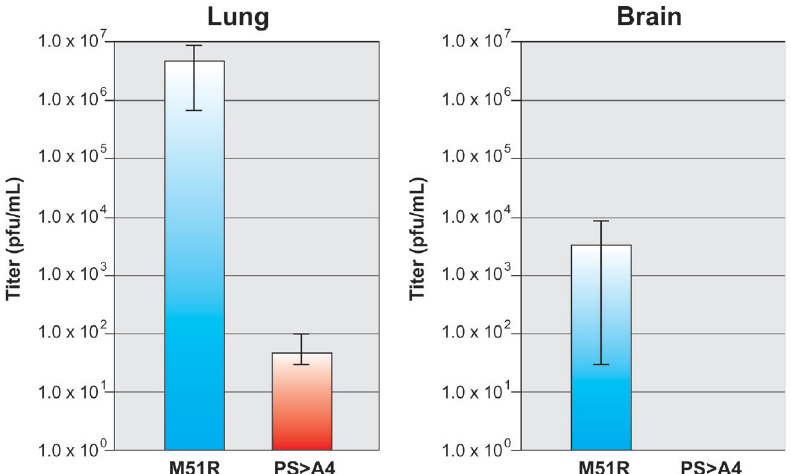
Figure 4. Replication of virus in the lungs and brains of infected mice. Three mice initially infected with 10 7 p.f.u. of M51R or PS > A4 were sacrificed at 2 d.p.i., and the average viral titers (p.f.u./mL) from lung and brain homogenates were determined using a standard plaque assay on BHK-21 cells performed in